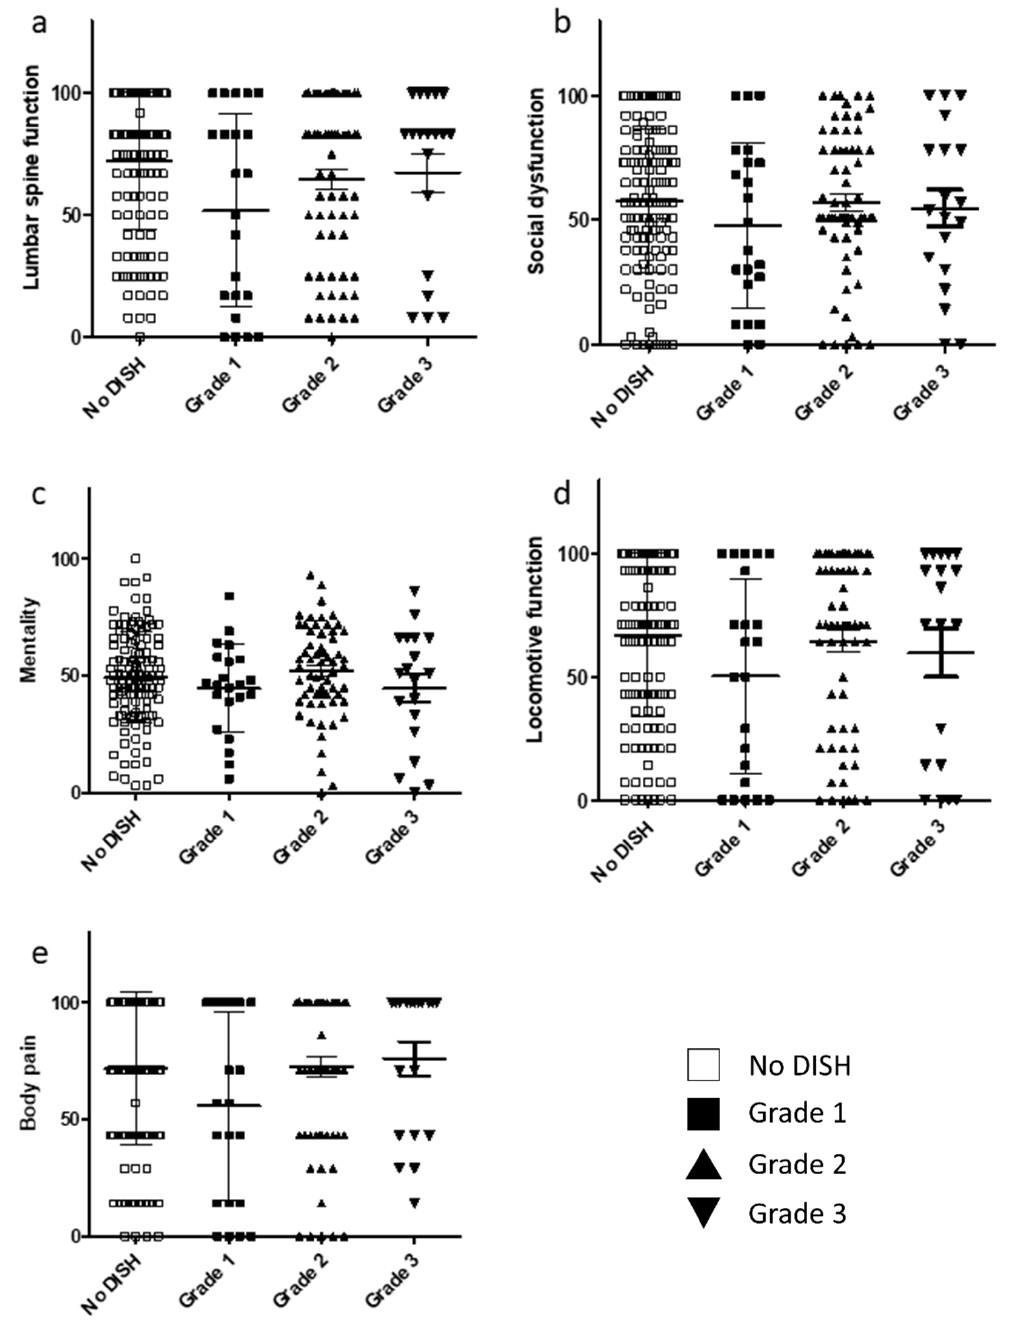
Figure 4. Relationship between JOA-BPEQ and DISH grade. ( a ) Lumbar function. ( b ) Social dysfunction. ( c ) Mentality. ( d ) Locomotive function. ( e ) Body pain. DISH, diffuse idiopathic skeletal hyperostosis; JOA-BPEQ, Japanese Orthopaedic Association Back Pain Evaluation Questionnaire.